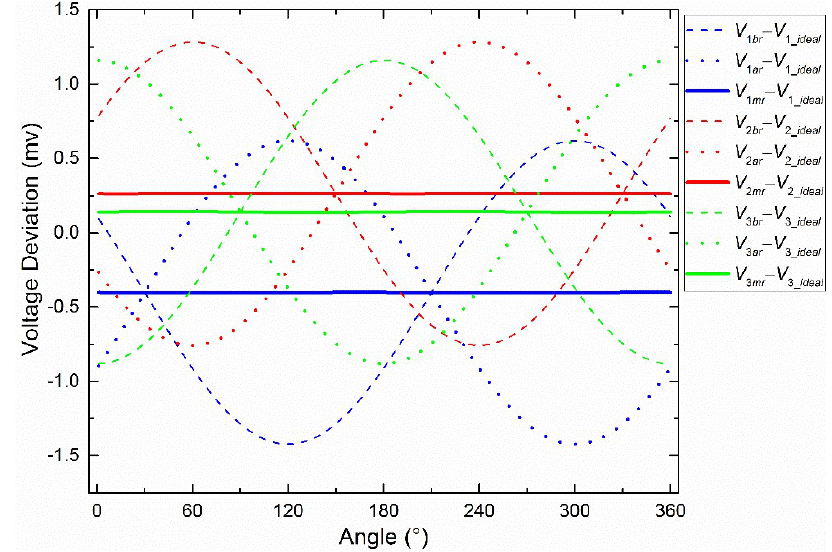
Figure 9. The integrated influence of O IS and O S when L IS = 0.05 mm, α IS = 0 ◦ , L S = 0.02 mm, and α = 70 ◦ .